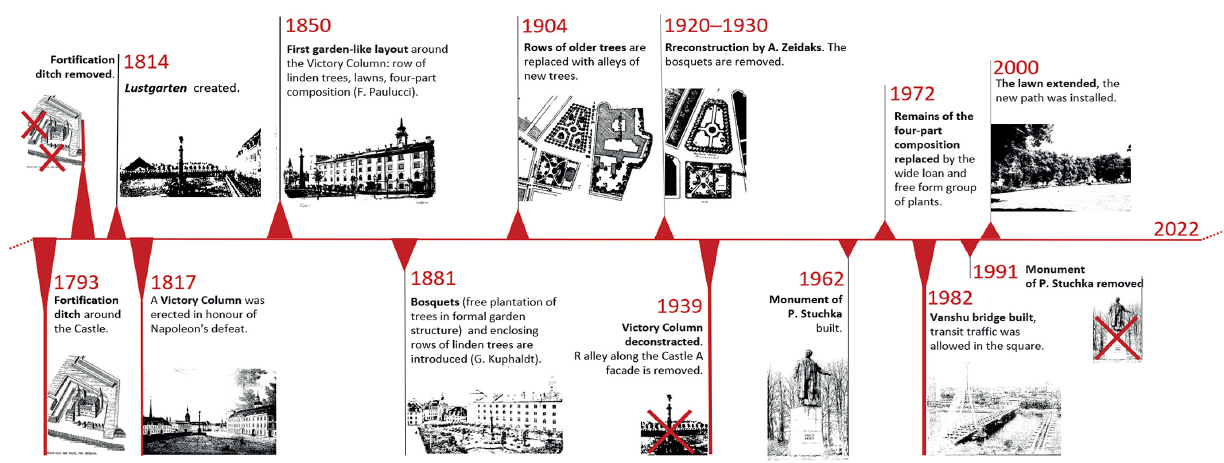
Figure 6. Chronological line showing the rhythm and pace of spatial changes. Source: Author’s work based on Zudusī Latvija